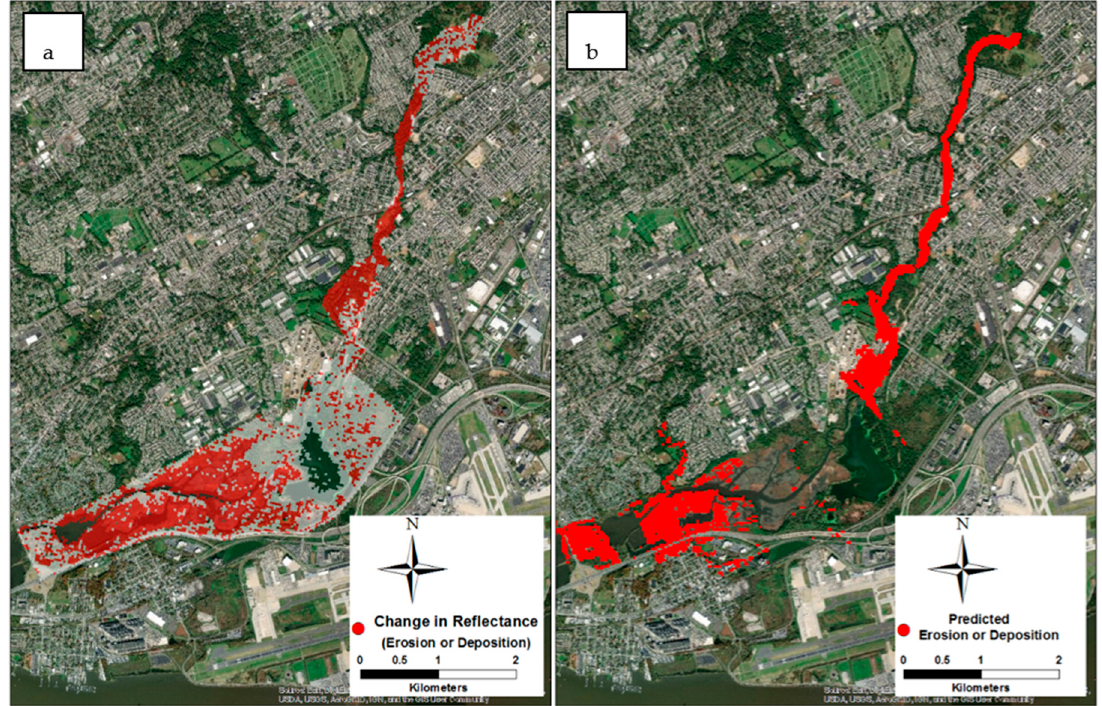
Figure 7. Measured and simulated morphological alterations in Darby Creek from July to September 2011 were compared for model verification; ( a ) represents land surface change detected by Landsat images, and ( b ) represents land surface change by erosion or deposition estimated by the integrated model.